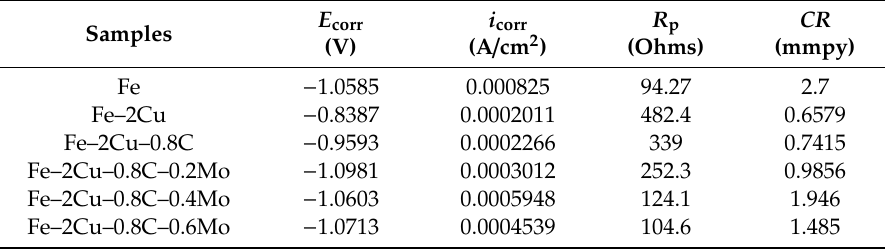
Figure 5. Potentiodynamic polarization curves of carbonyl iron powder compacts sintered substrates. ( a ) Fe, ( b ) Fe–2Cu, ( c ) Fe–2Cu–0.8C, ( d ) Fe–2Cu–0.8C–0.2Mo, ( e ) Fe–2Cu–0.8C–0.4Mo, and ( f ) Fe–2Cu–0.8C–0.6Mo. Table 6. Potentiodynamic polarization values attained from the electrochemical experiment for carbonyl iron powder compacts sintered substrates.